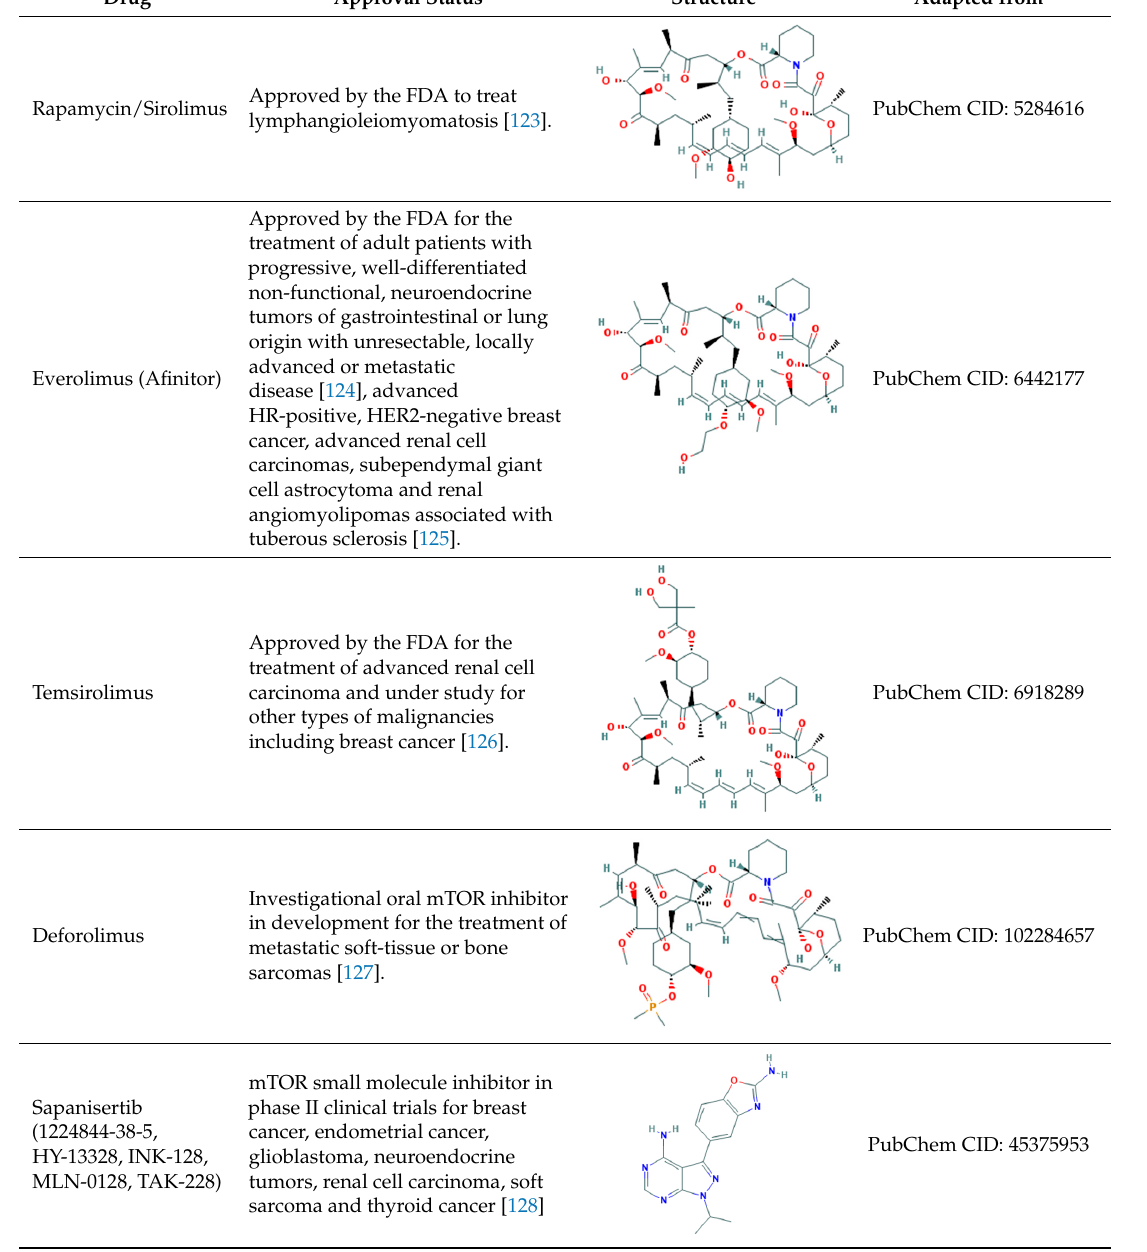
Table 11. PI3K inhibitors.